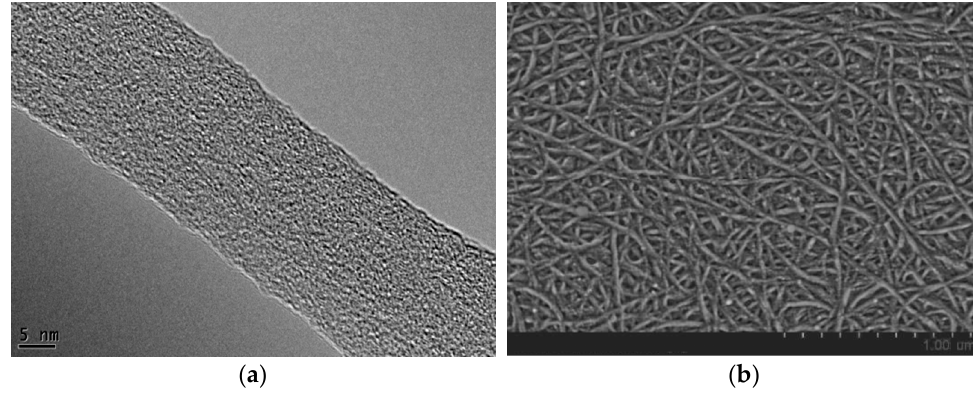
Figure 2. ( a ) HRTEM image of the microstructure of a SWCNT, ( b ) SEM image of SWCNTs conduc- tive networks.